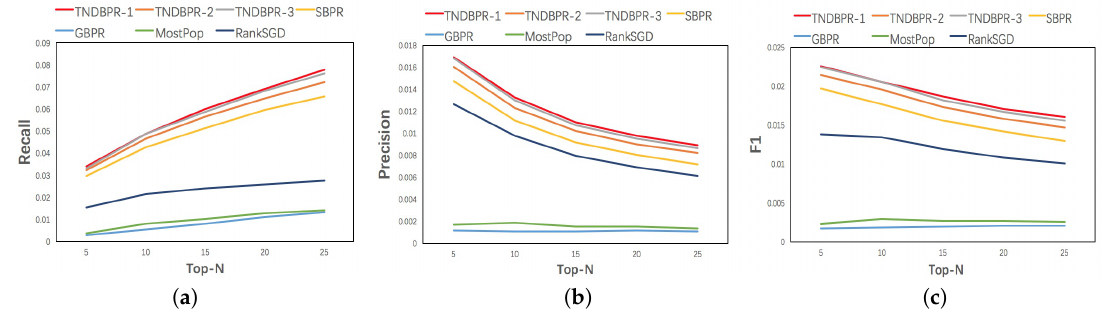
Figure 3. Top- N Analysis. ( a ) Recall; ( b ) Precision; ( c )